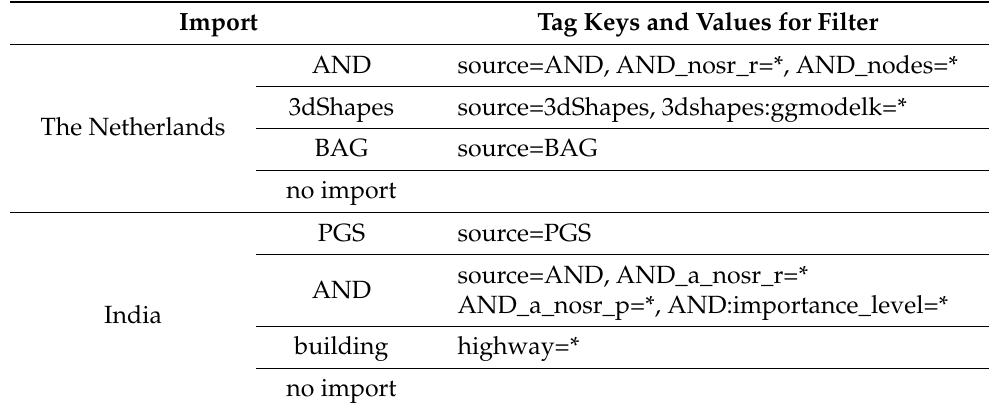
Table 5. Tag keys and values used to filter out imported elements during the respective observation periods. The asterisks (*) is a placeholder for any value. If multiple tag keys were used for one import (e.g., AND imports), the filters were chained with an “OR” condition. For the periods without an import (control group), no filter was applied. Import Tag Keys and Values for Filter AND source=AND, AND_nosr_r=*, AND_nodes=* 3dShapes The Netherlands